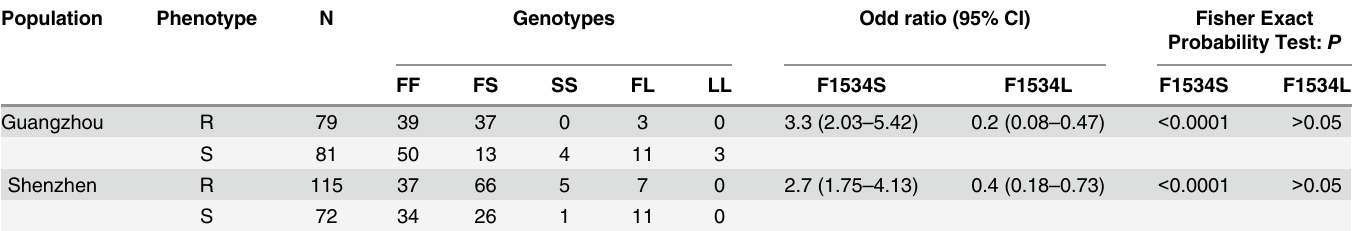
Table 3. Genotyping results of voltage-gated sodium channel gene at 1534 codon and association between kdr mutation and phenotypic resis- tance in two deltamethrin resistant and susceptible Aedes albopictus populations from southern